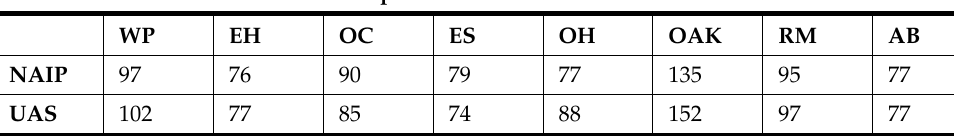
Table 7. Reference data samples sizes by class for individual tree classifications conducted using the UAS and NAIP automated approaches. Additional acronyms include other conifer (OC) and other hardwood (OH).